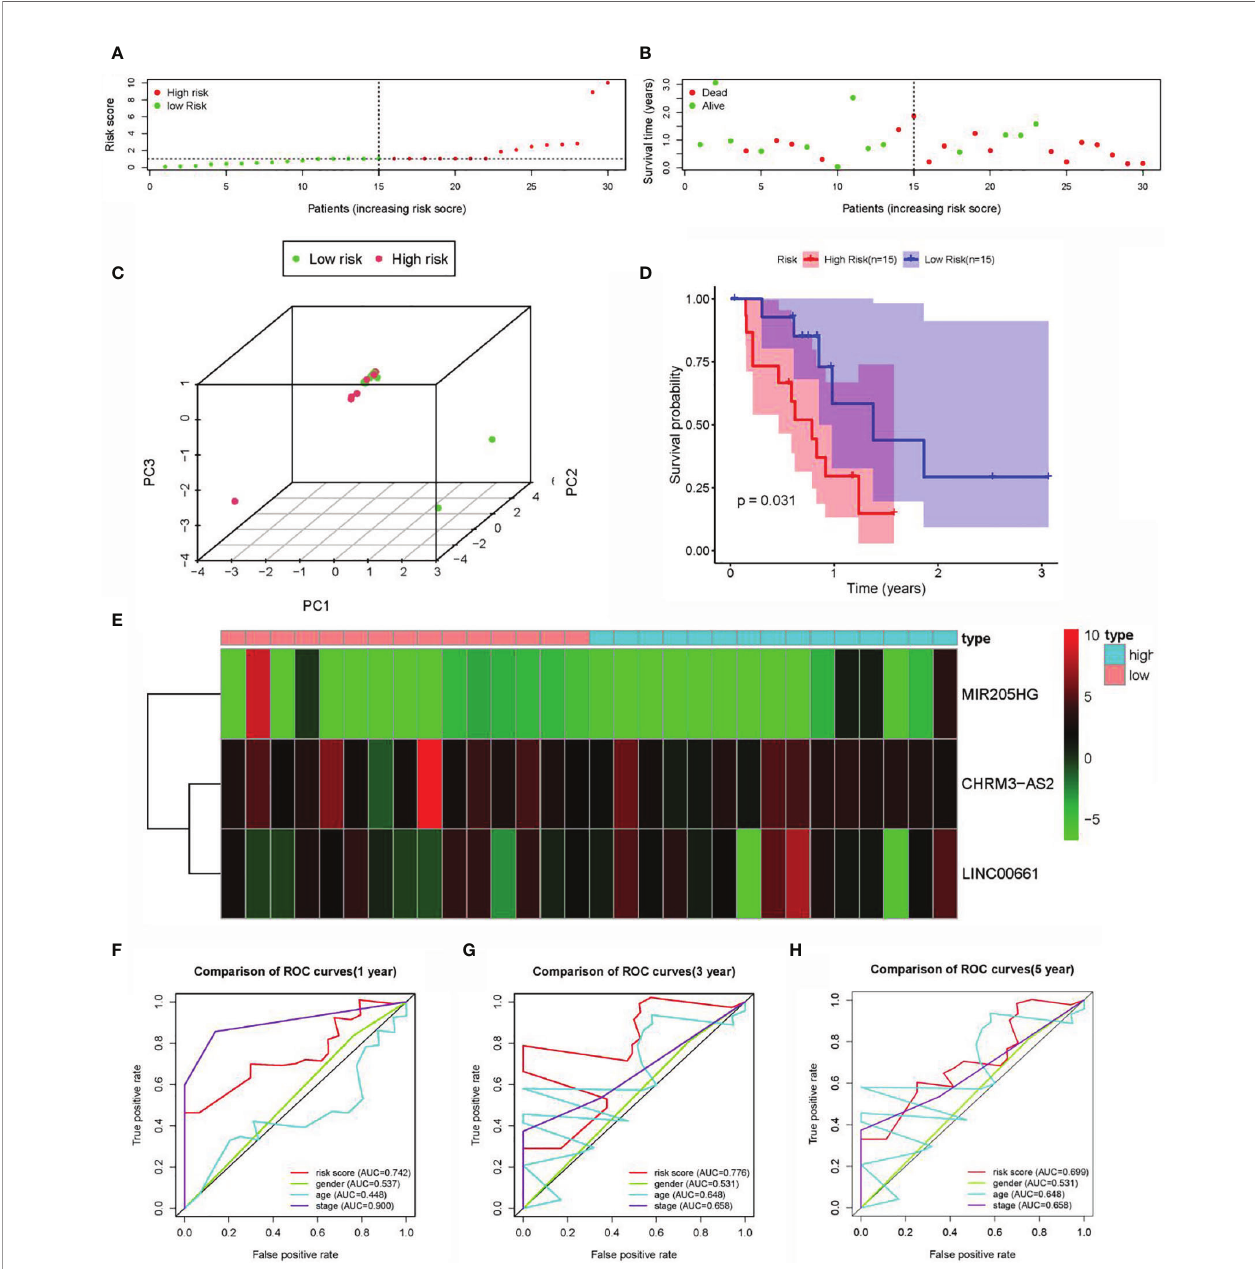
FIGURE 5 | Construction of the prognostic DEARlncRNA signatures for CCA patients using GEO datasets. (A) Distribution of CCA patients with high- and low-risk scores. (B) Survival status of CCA patients with high- and low-risk scores. (C) PCA of the expression pro fi les of CHRM3.AS2, MIR205HG, and LINC00661. (D) The K-M curve analysis in high-risk ( n = 15) and low-risk ( n = 15) patients. (E) The heatmap of the expression pro fi les of CHRM3.AS2, MIR205HG, and LINC00661. (F) The 1-year time-dependent ROC curve. (G) The 3-year time-dependent ROC curve. (H) The 5-year time-dependent ROC